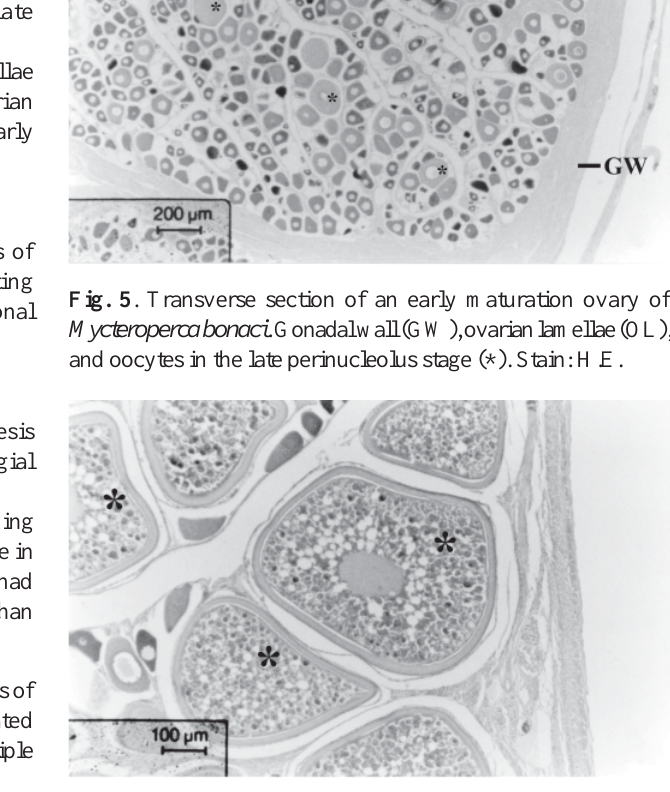
Fig. 6. Transverse section of a ripe ovary of Mycteroperca bonaci showing great amount of oocytes in the final phases of vitellogenic growth (*). Stain: H.